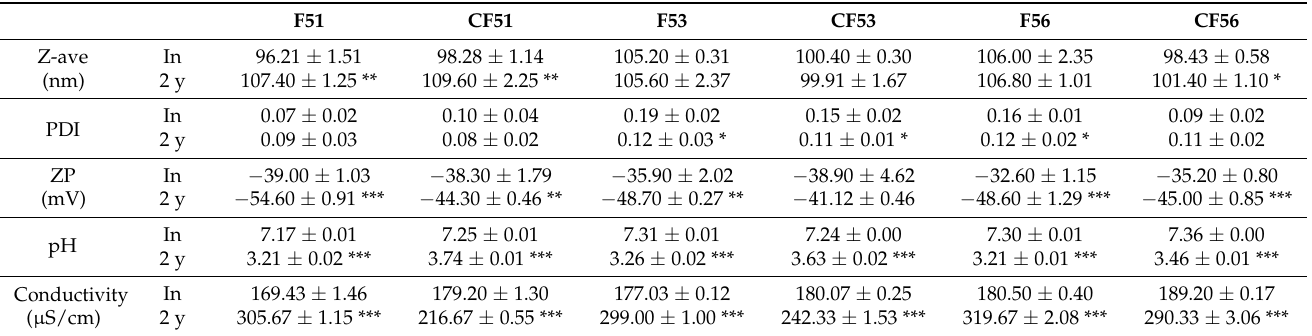
Table 8. Physicochemical parameters for fish oil nanoemulsions containing PEG5000-DPPE measured initially (In) and after two years of storage at room temperature (2 y).